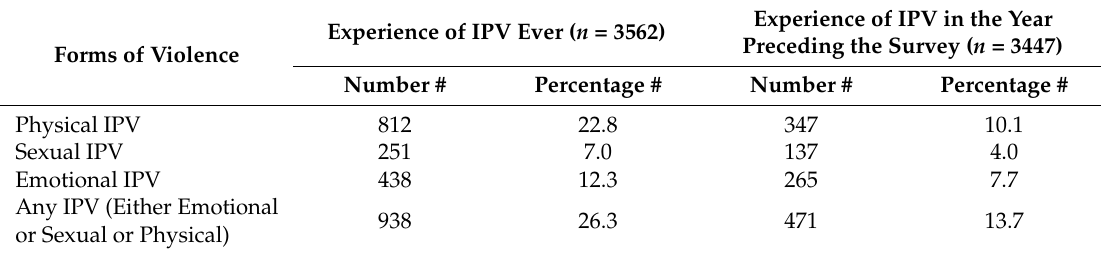
Table 4. Prevalence of experience of intimate partner